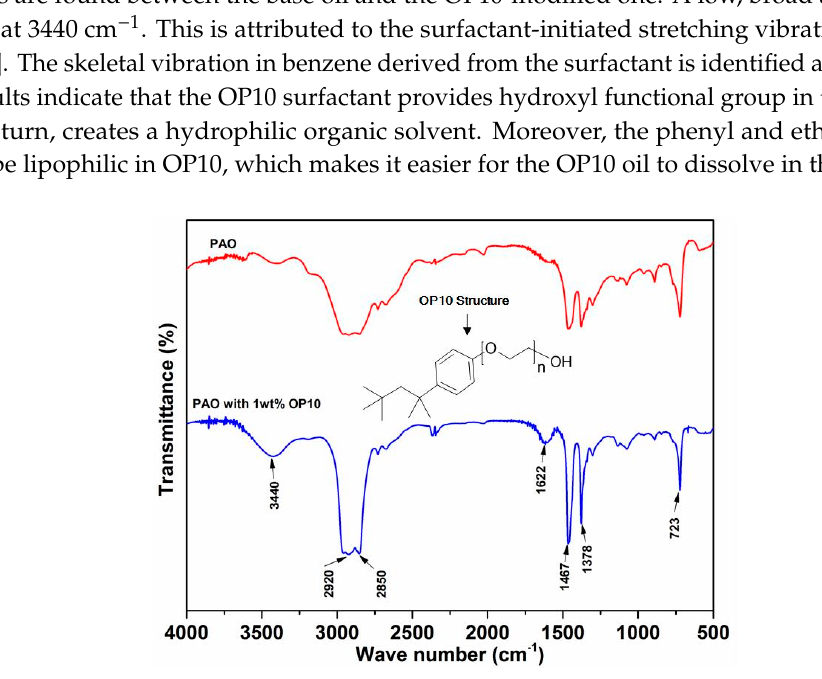
Figure 4. The FTIR spectra of base oil with and without added surfactant.